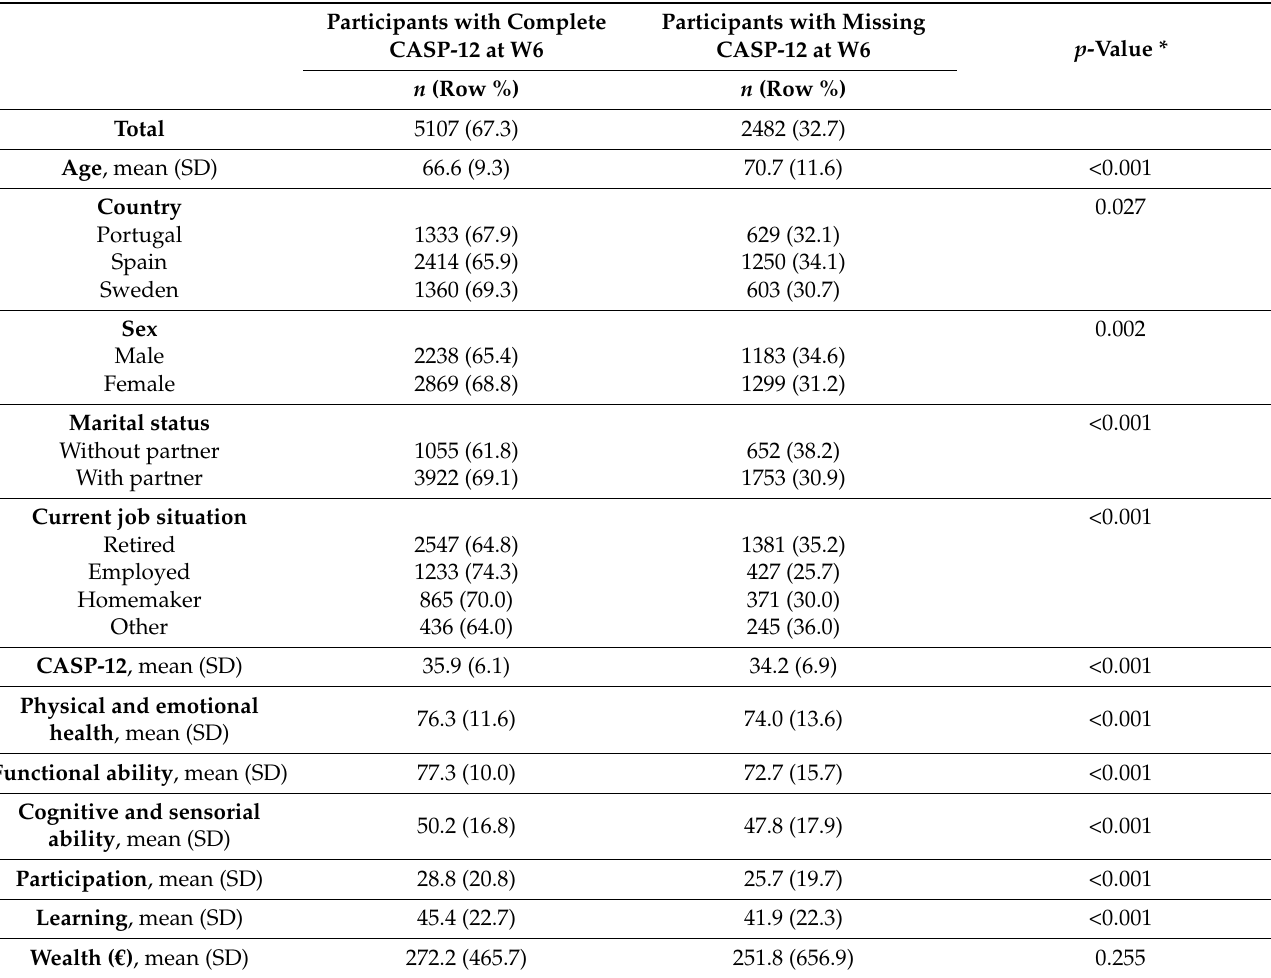
Table 1. Baseline descriptive statistics of participants with complete and missing CASP-12 at W6 (unweighted).